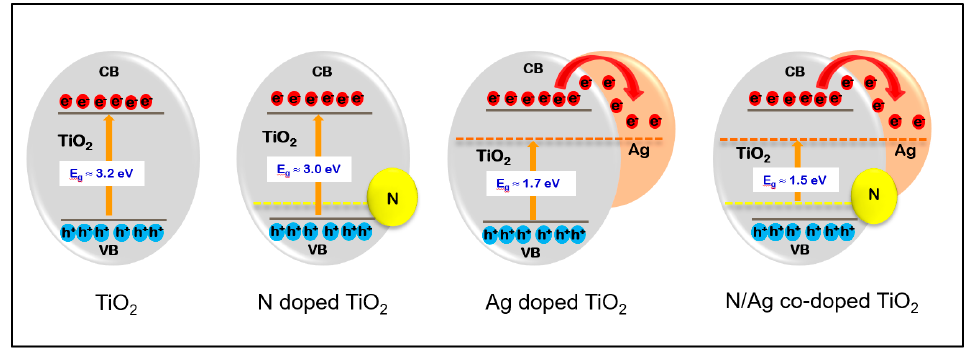
Figure 6. Schematic diagrams of the band energy structure and the migration of photoexcited electrons in undoped TiO 2, N-TiO 2 , Ag-TiO 2 , and N/Ag-TiO 2 .